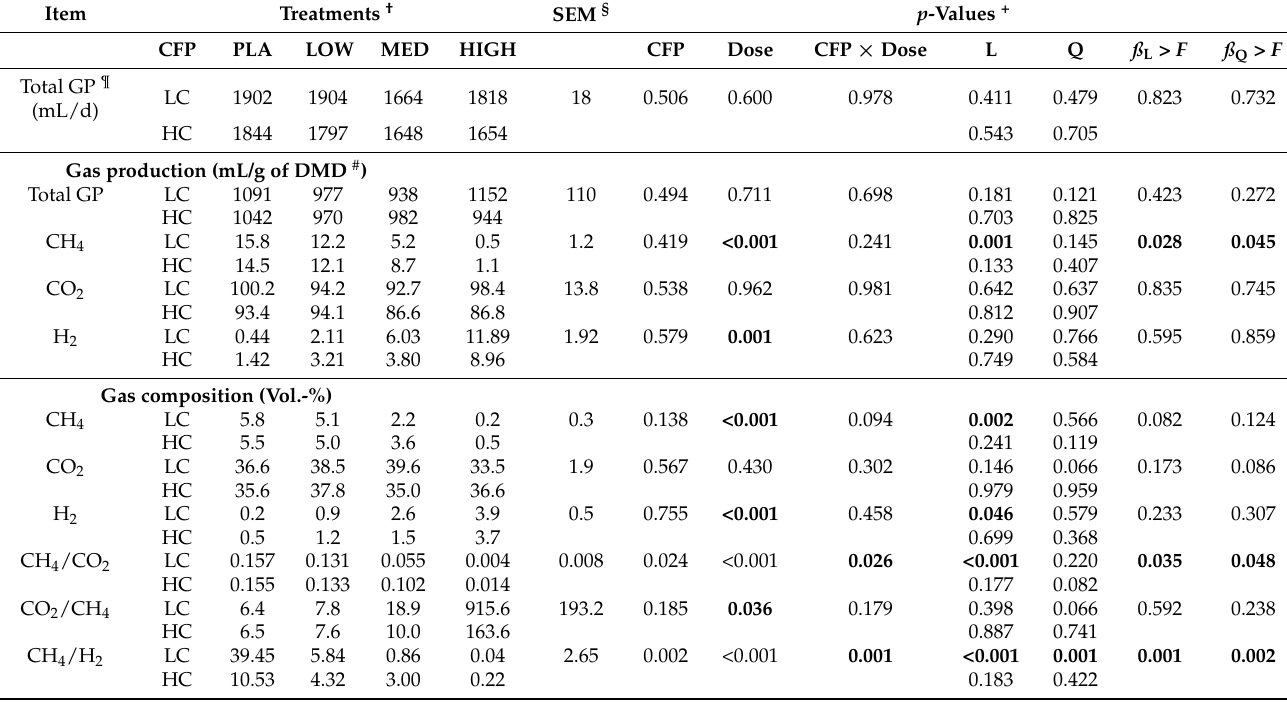
Table 3. Effects of 3-nitrooxypropanol (3-NOP) dosage levels (PLA: 0, LOW: 73, MED: 160, and HIGH: 1200 mg of 3-NOP/kg of feed DM) and low- (LC) or high- (HC) concentrate feed proportion in the diet (CFP) on fermentation gas production and